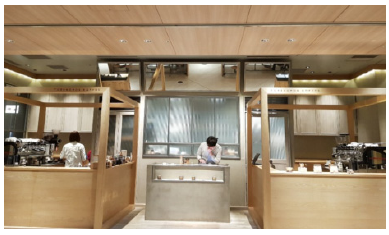
Figure 12. ToranomonKoffee (2014, Tokyo, Japan).